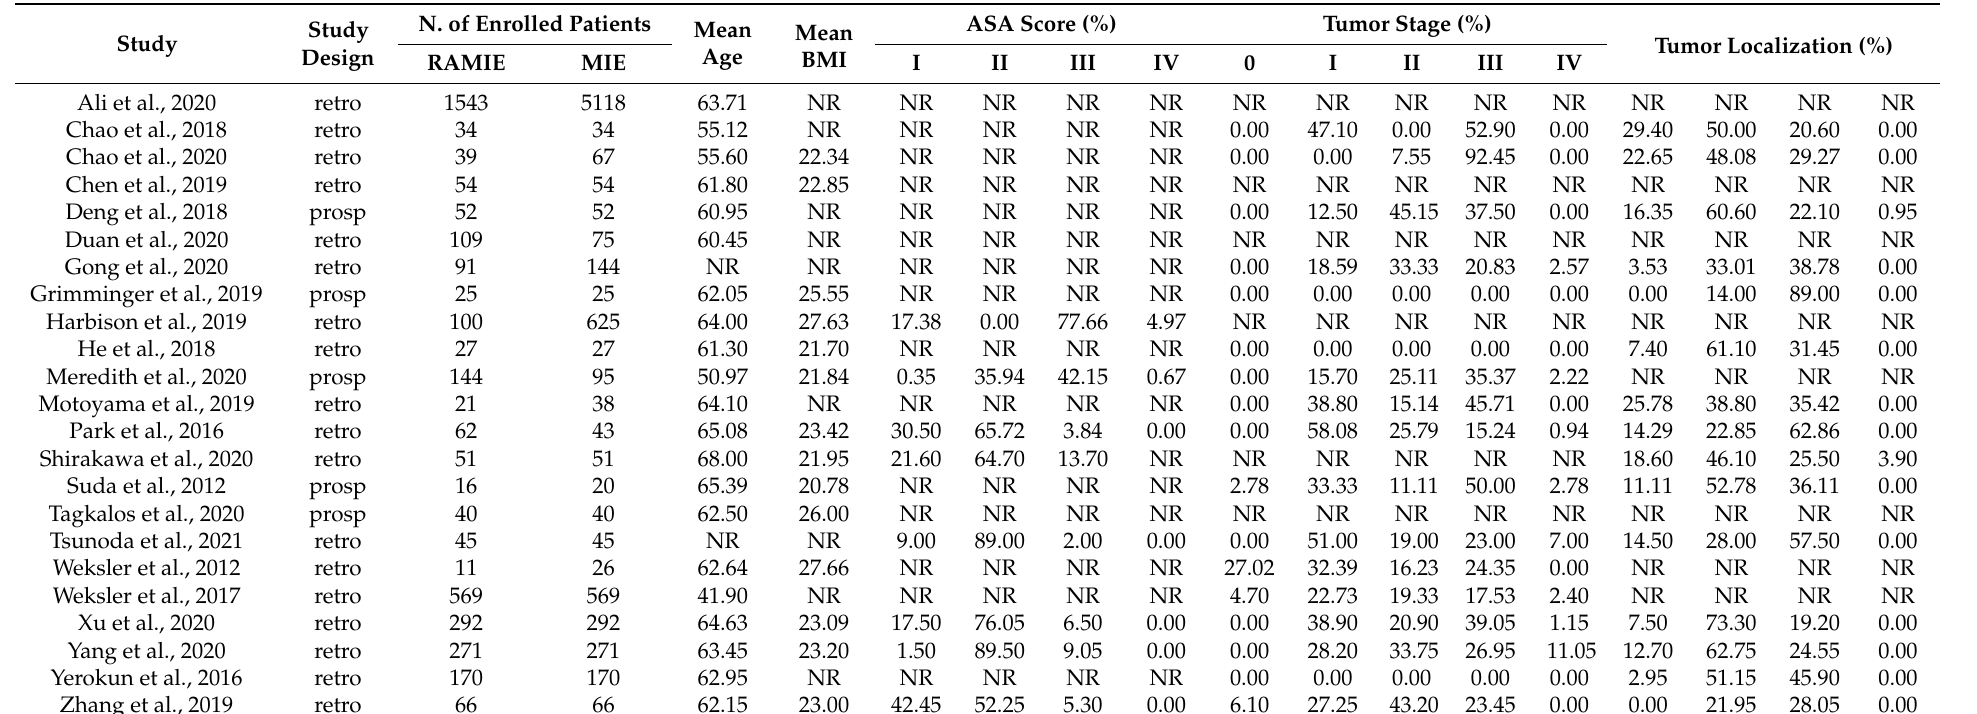
Table 1. Characteristics of the included studies comparing robotic and laparoscopic